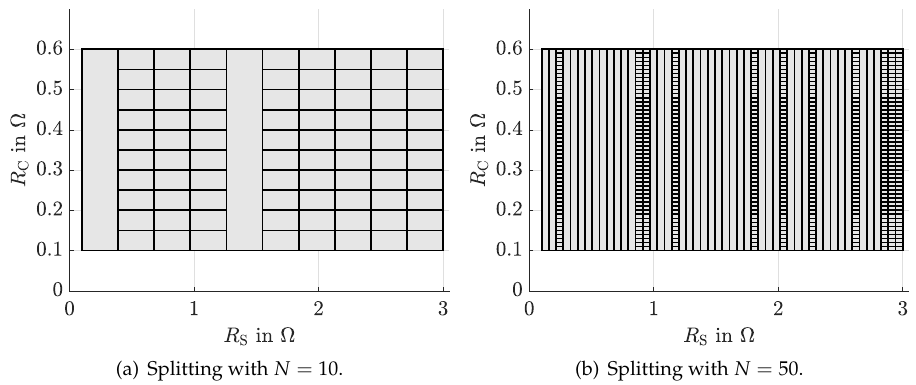
Figure 5. Partitioning of the parameter domain according to Section 3 for two different parameteriza- tions of the multi-sectioning